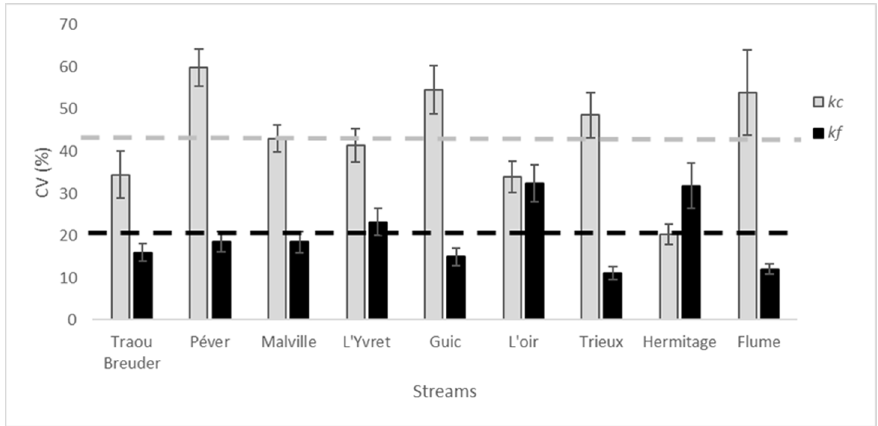
Figure 2. Mean values (±SE) of ( a ) total decomposition ( kc ), and ( b ) microbial decomposition ( kf ) in each riffle for the 9 streams.